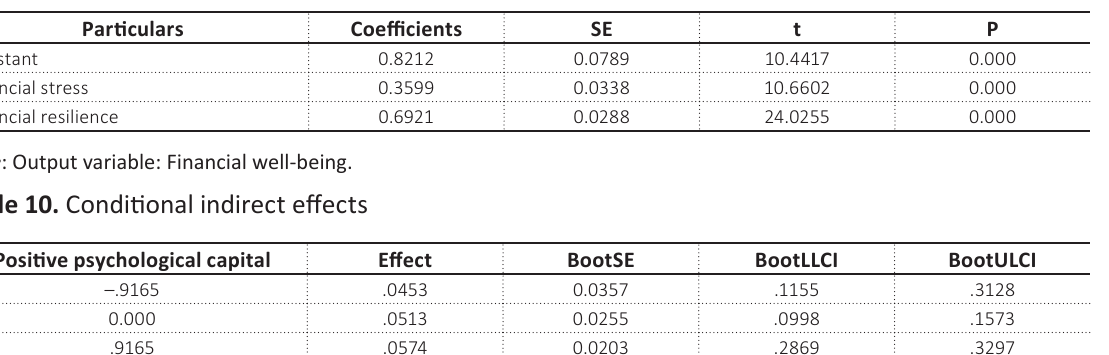
Table 9. Model coefficients